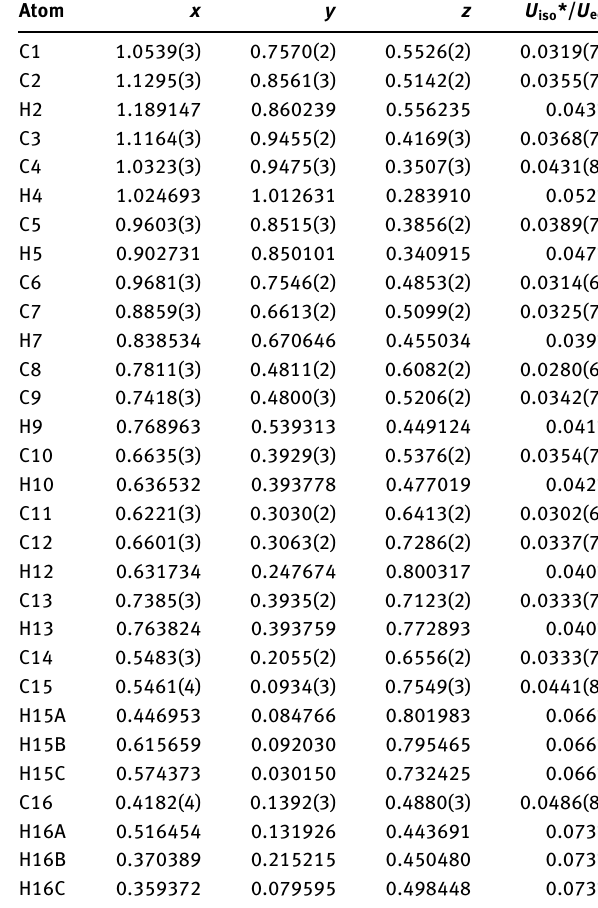
Table 2: Fractional atomic coordinates and isotropic or equivalent isotropic displacement parameters (Å 2